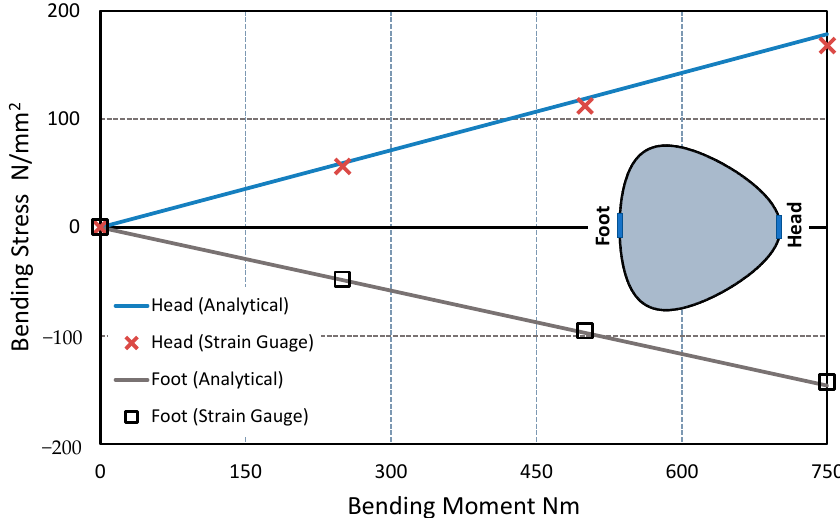
Figure 9. Comparison of the experimental results with the analytical solutions.